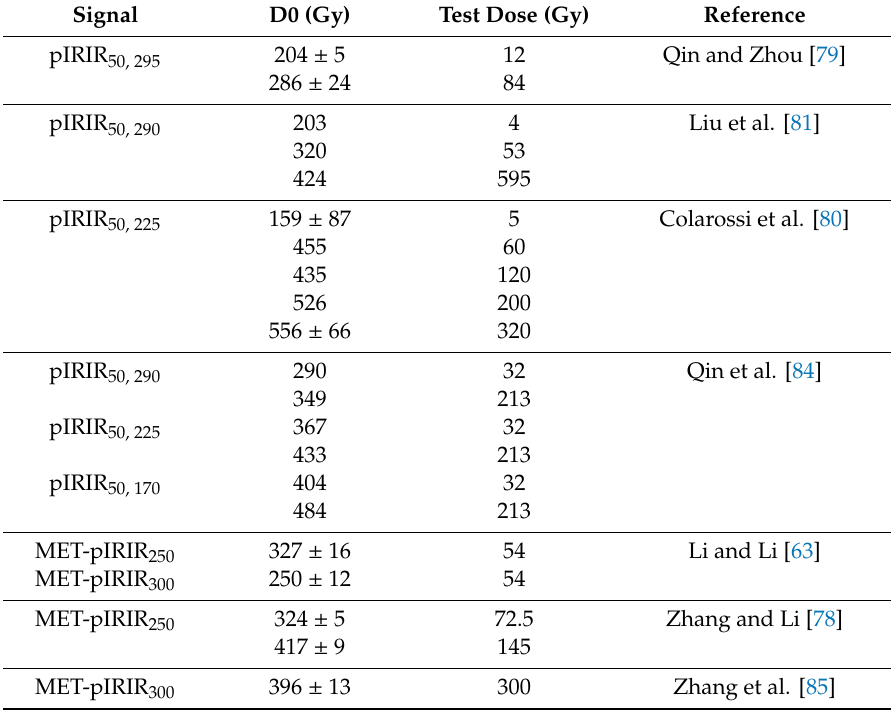
Figure 2. Characteristic saturation dose (D 0 ) of the pIRIR signals versus the test dose (D t ), with the SAR protocol. Data are from Table 2. A general positive relationship exists between D 0 and D t . Please note that the pIRIR signals in this graph includes di ff erent kinds of signals, such as pIRIR 50, 170 , pIRIR 50, 225 , pIRIR 50, 290 , MET-pIRIR 250 / 300 signals. So the D 0 is scattered even with the same D t . Table 2. Characteristic saturation dose (D 0 ) of the growth curves from the conventional SAR protocol with di ff erent pIRIR